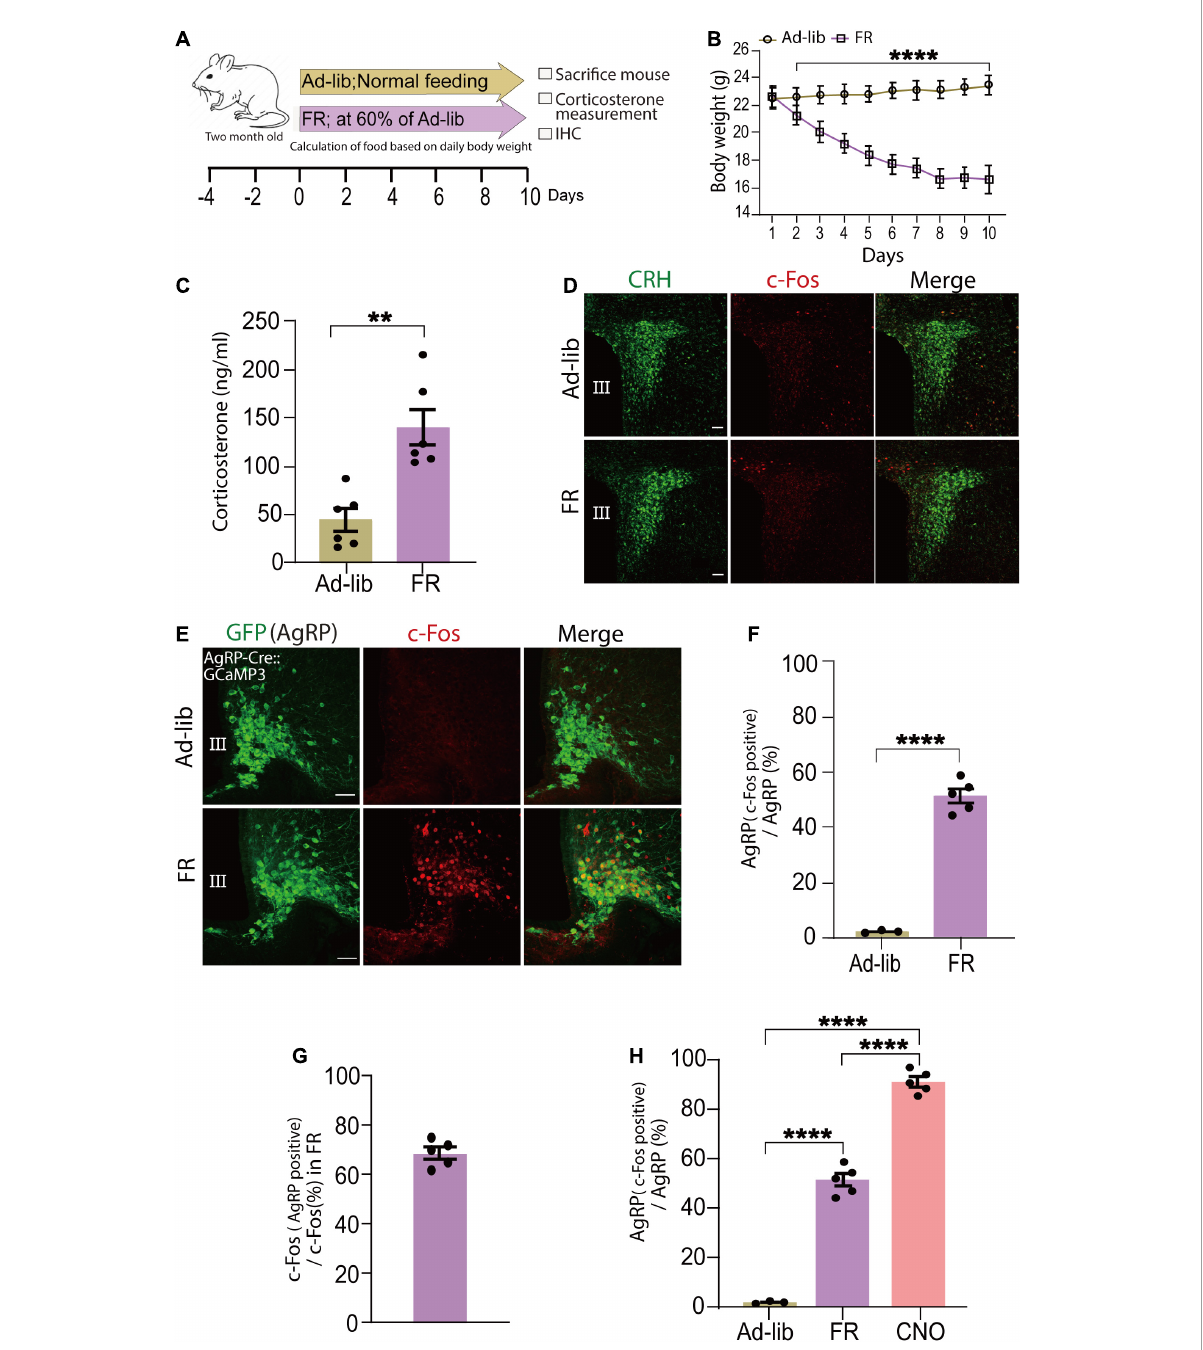
FIGURE3 Food restriction (FR) activates agouti-related peptide (AgRP) neurons and increases serum corticosterone levels. (A) Schematic diagram of 60% FR for 10 days. FR was applied every day at 6 p.m. in wild-type adult male mice. (B) FR significantly decreased body weight; **** P < 0.0001, unpaired Student’s t test. (C) Plasma corticosterone levels at 9.00 a.m.–11.00 a.m. was significantly increased in the FR group; ** P < 0.0013; unpaired Student’s t test. (D) c-Fos expression was not observed in the PVN area of ad libitum (Ad-Lib) or FR groups. Scale bars, 50 µ m. (E) Confocal image showing c-Fos expression in AgRP neurons in the arcuate nucleus (ARC) stained with an anti-GFP antibody in AgRP-Cre:GCaMP3 mice. Scale bars, 40 µ m. (F) Expression of c-Fos in AgRP neurons (51.3% ± 1.7%) was significantly increased by FR; **** P < 0.0001, unpaired Student’s t test. (G) Approximately 68.53% ± 2.04% of c-Fos-expressing neurons were AgRP neurons in ARC of FR group. (H) AgRP neurons expressing c-Fos in the ARC after clozapine N-oxide (CNO) injection (91.1% ± 2%) were significantly more than that by FR; **** P < 0.0001; unpaired Student’s t test. Error bars represent